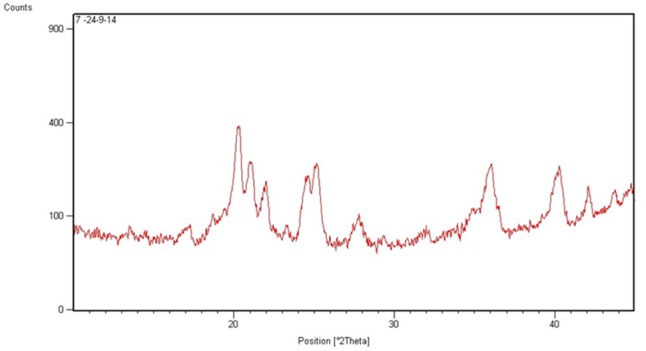
XRD spectra of Cur-PLGA nanoparticles.